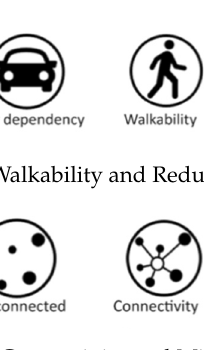
Figure 12. Promote Connectivity and Minimize Isolation.